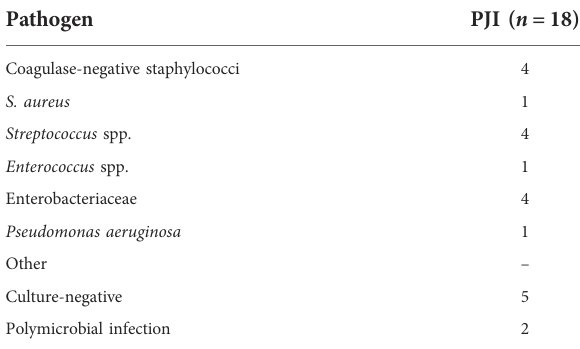
TABLE 3 Spectrum of